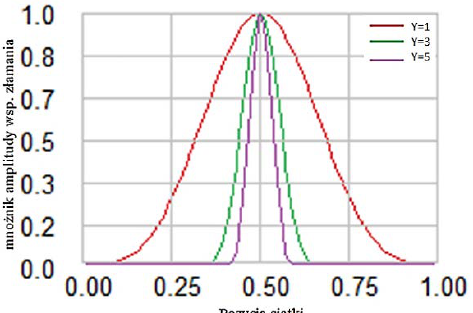
Fig. 18. Sine apodization function for different values of the parameter Y at constant value X=3.